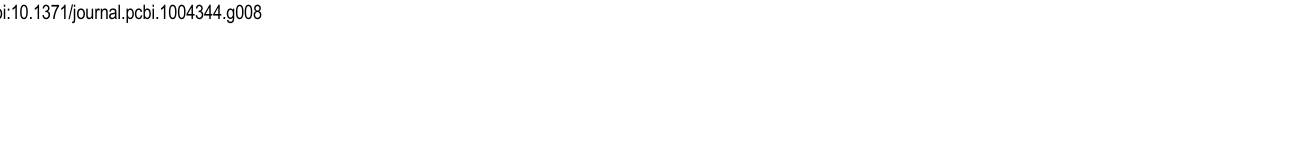
Fig 8. Three mutations between three segments that indicate two re-assortment events. (A) Mutation prevalences across time series. (B) One of 51 recombination networks that fit the data. (C) Two phylogenetic networks that fit the data ((i) and (ii)-(iv)), corresponding to four clonesets. (D) Prevalence ranges for the four